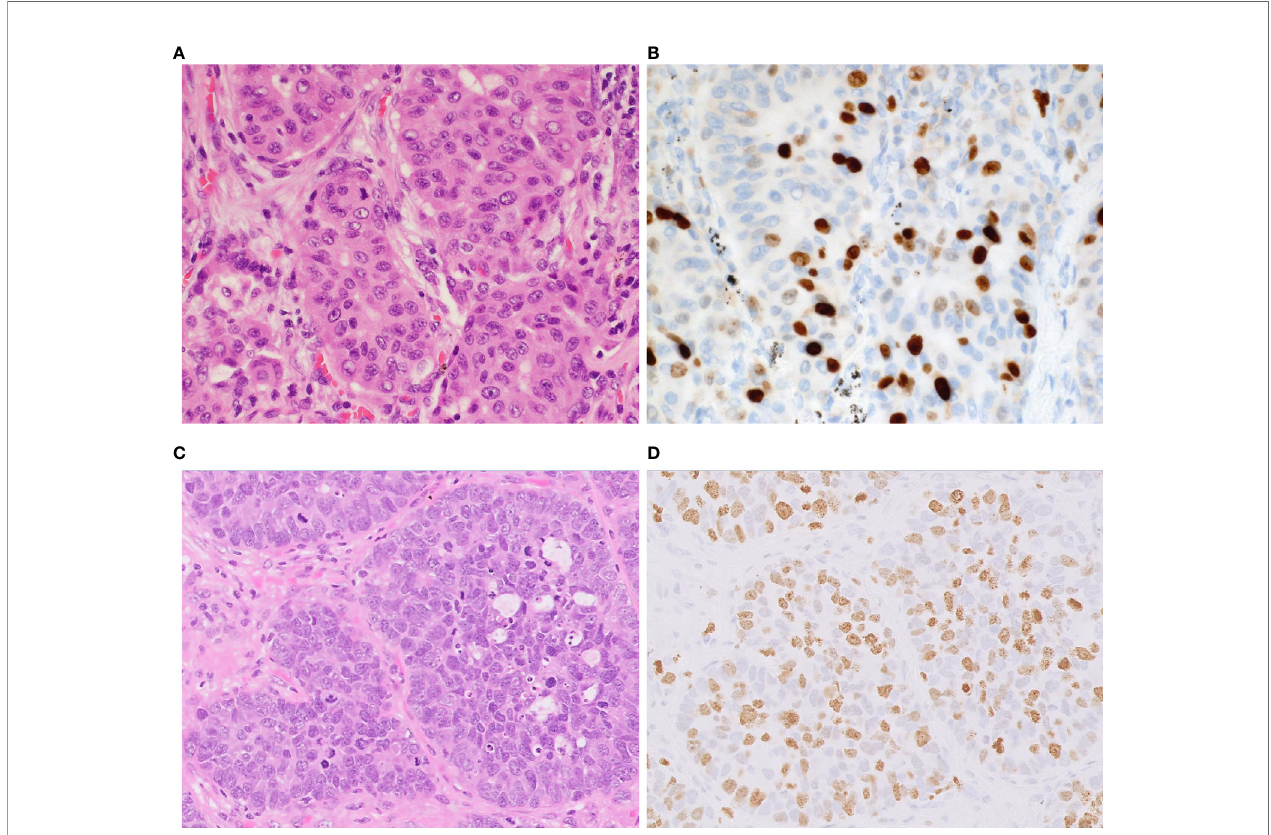
FIGURE 5 | Proliferation index in atypical carcinoid vs. LCNEC. Representative examples of atypical carcinoid (A, B) and LCNEC (C, D) . (A) The tumor shows nests of carcinoid tumor cells. (B) The Ki-67 proliferative index is approximately 20%. (C) The tumor shows nests and palisading patterns of LCNEC tumor cells. (D) The Ki-67 proliferative index is approximately 60%. Magni fi cation: